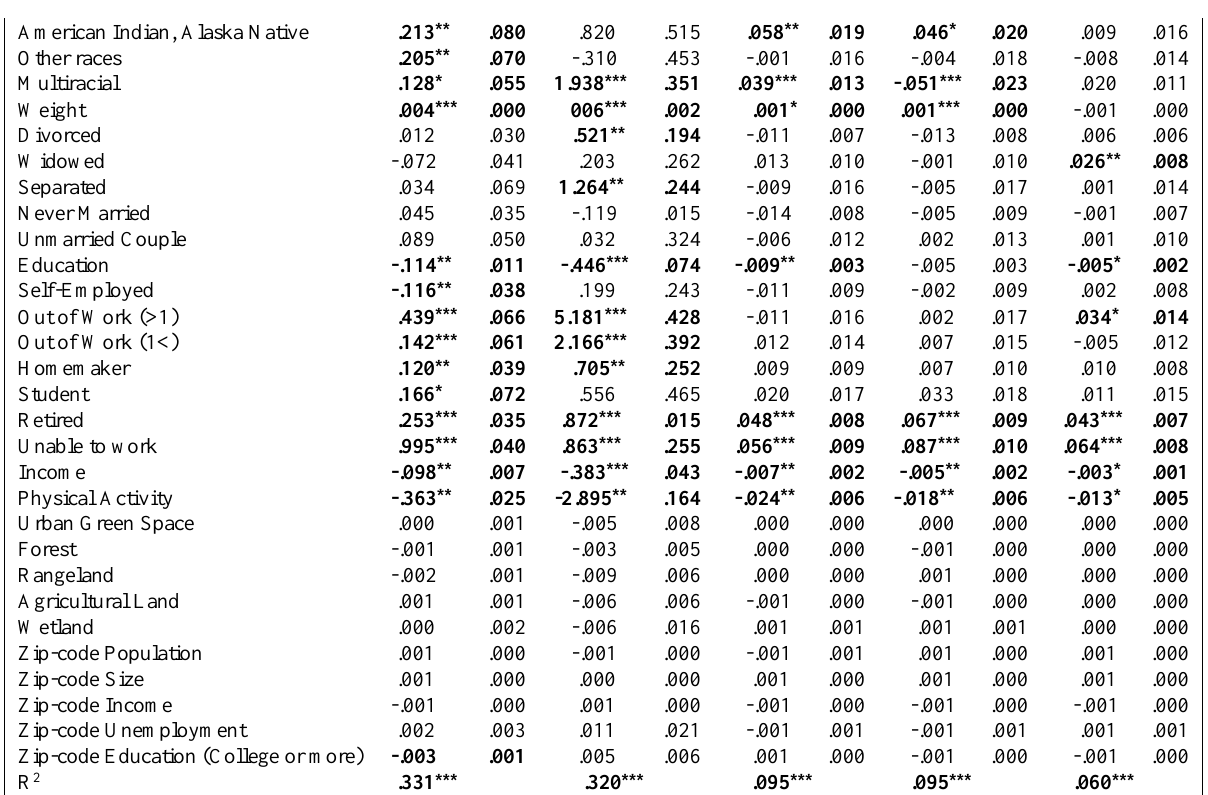
Table 3. The associations between types of green space, PA, and health